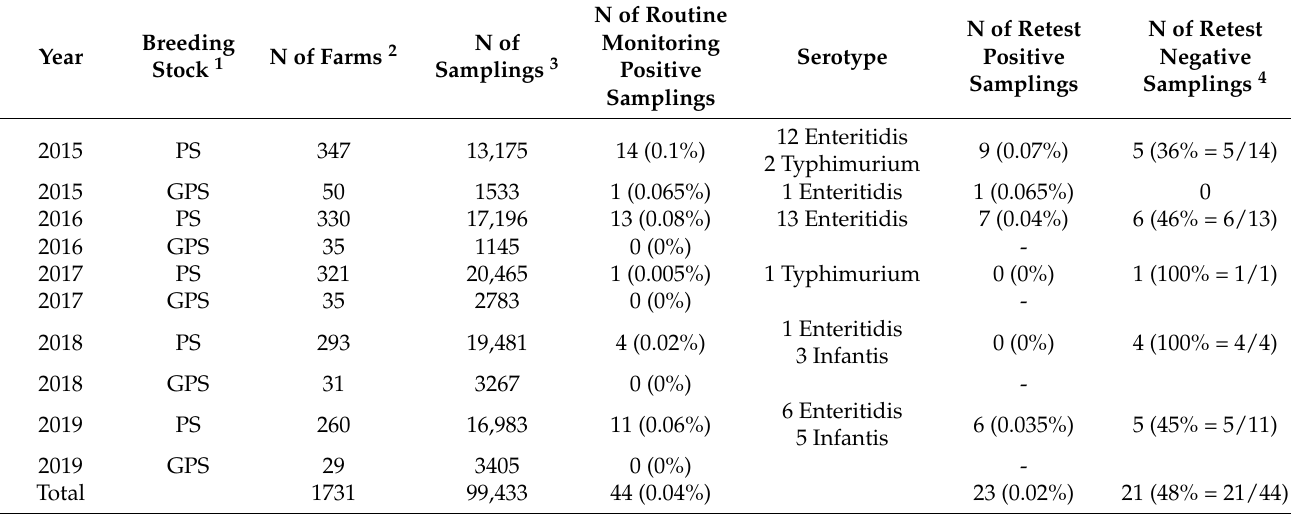
Table 1. Results from the Dutch national control program for Salmonella ; routine Salmonella monitoring positive samplings, in relation to the total number (N) of Salmonella samplings in Dutch poultry breeding farms by